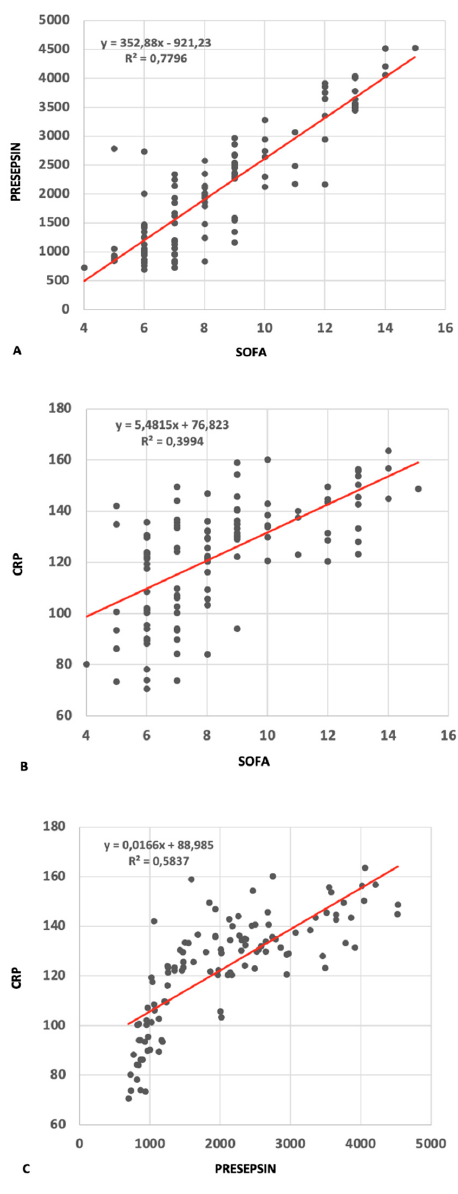
Figure 2. Correlations between presepsin-Sequential Organ Failure Assessment (SOFA) ( A ), C reac- tive protein (CRP)-SOFA ( B ), and CRP-presepsin ( C ) in patients with sepsis. Correlation equations and R 2 values provided within